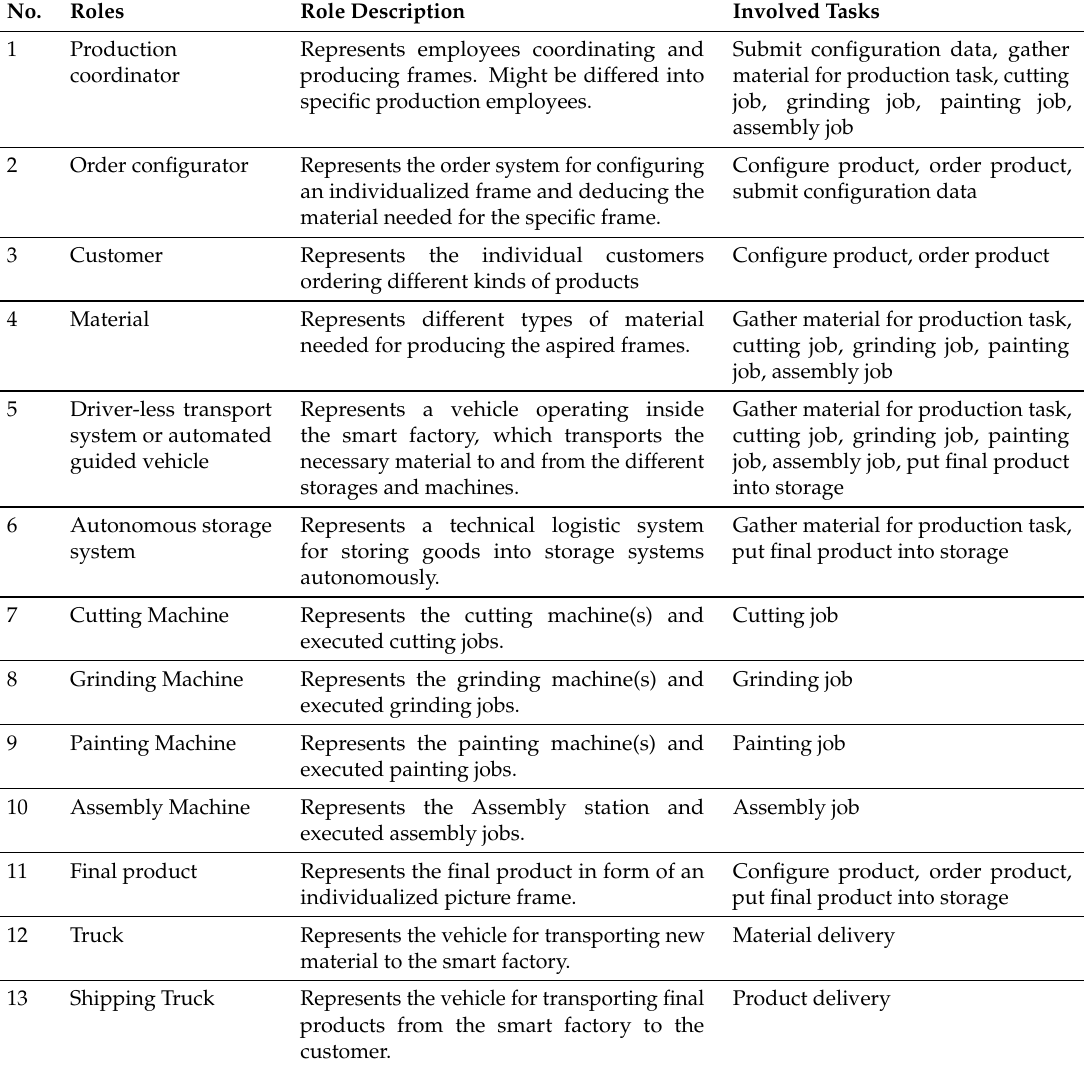
Table 2. Roles and tasks in the production